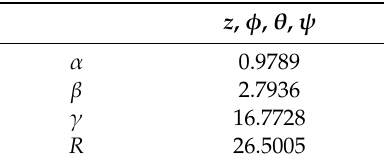
Table 4. ITD parameters of the leader quadrotor.